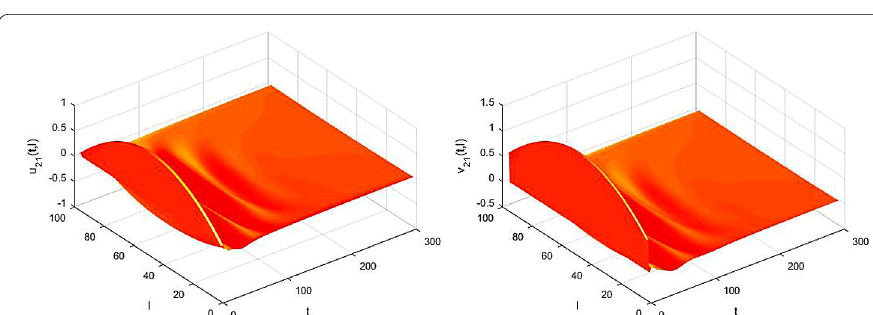
Figure 6 The trajectory of u 21 ( t , l ) and v 21 ( t , l ).